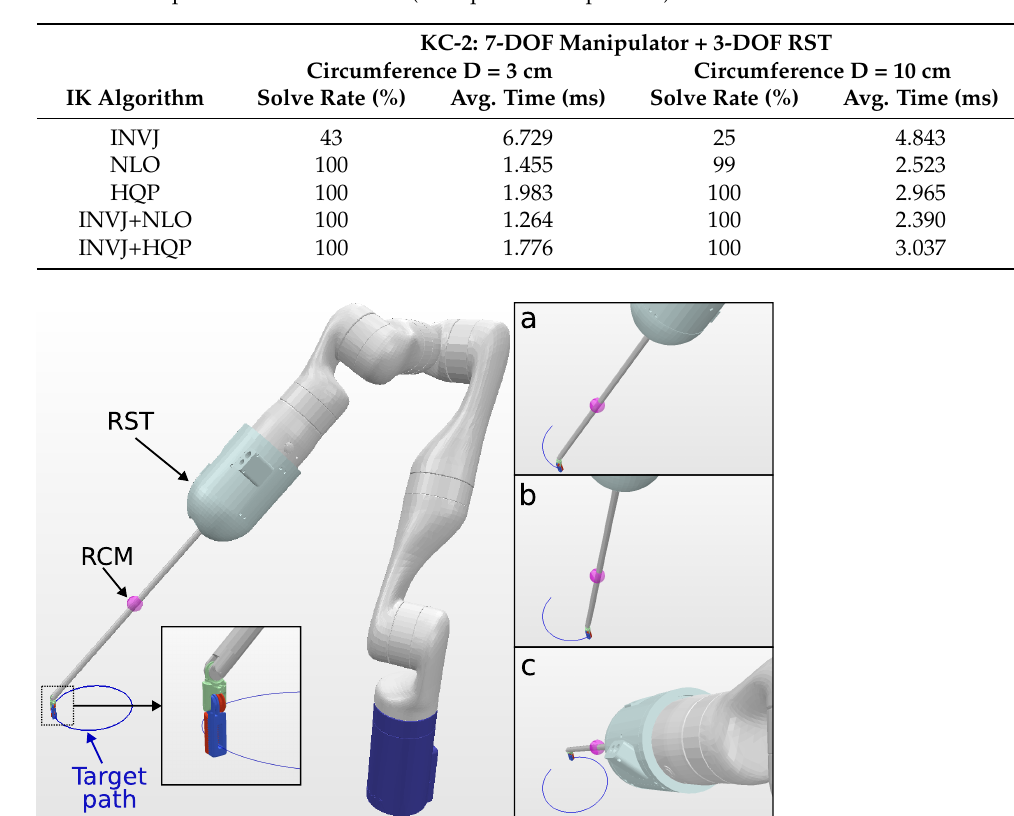
Table 5. A comparison of the solve rate and the solving time for single-method and concurrent IK algorithms. The target trajectories are two circular paths with diameters of 3 cm and 10 cm. Evaluation is performed for the KC-2 (Manipulator + OpenRST) kinematic chain.